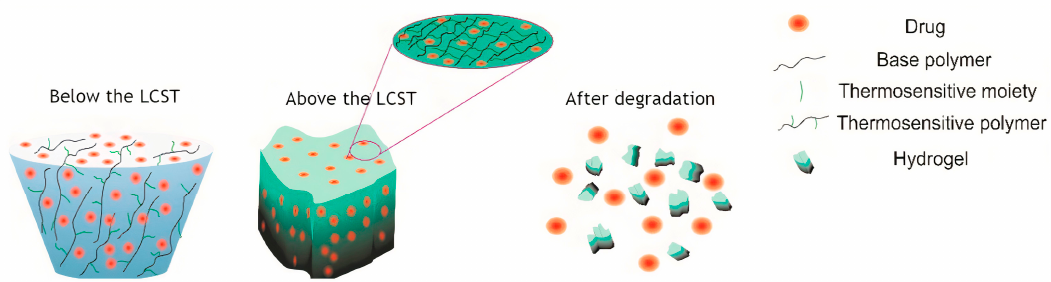
Figure 6. Hydrogel drug delivery system for in situ formation of scaffolds. Reprinted with permission from Ghaeini et al. Thermoresponsive Nanogels Based on Different Polymeric Moieties for Biomedical Applications. Gels 6(3). Copyright (2020) MDPI [205].